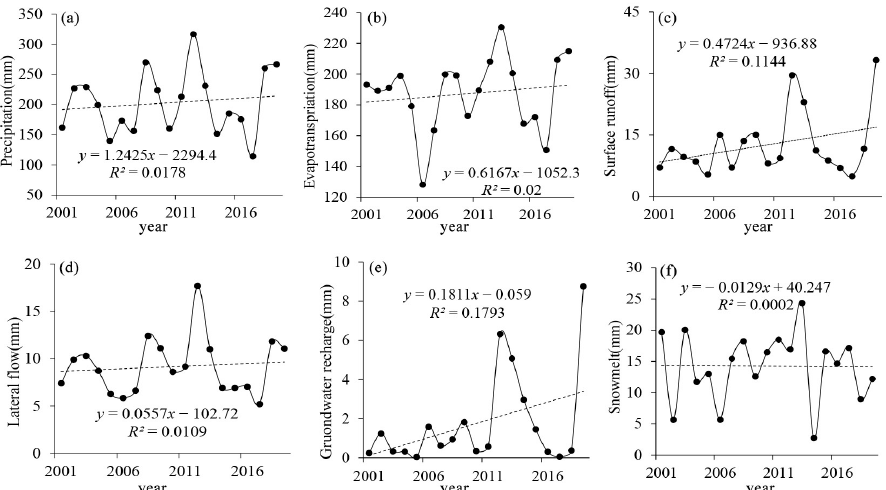
Figure 3. Characteristics of interannual variation in the URB’s hydrological process factors from 2001 to 2019: ( a ) precipitation, ( b ) ET, ( c ) surface runoff, ( d ) lateral flow, ( e ) groundwater recharge, and ( f ) snowmelt. Great spatial heterogeneity was observed in the spatial distribution and variation rates of the URB’s different hydrological process factors (Figure 4). The annual total pre- cipitation in the upstream region of the basin was 457.48 mm, and it gradually decreased from east to west; the overall precipitation variation rate was high, with the fastest varia- tion reaching up to 2.033 mm/yr in the upstream, followed by that in the downstream (1.601 mm/yr; see Figure 4a). The ET in the southern part of URB reached 272.79 mm, while the ET in the northwestern part was lower at 261.74 mm, showing a decreasing trend from south to north. The rate of change was faster in the URB’s upstream and south- ern parts and slower in its northern and downstream parts (Figure 4b). The runoff deep high value of the URB’s runoff was mainly concentrated in the wetland area, decreasing from the wetland to the surrounding area. The rate of change varied similarly, with the downstream wetland area increasing at a rate of 8.23 mm/yr (Figure 4c). The lateral flow in the high-elevation area was higher than that in the low-elevation area; the lateral flow gradually increased from the URB’s wetland to the surrounding area, and the change rate showed the same spatial distribution characteristics as the lateral flow did (Figure 4d). Groundwater recharge reached 3.12 mm in the URB’s upper and western parts and was lower in the URB’s southern and northern parts (1.5 mm); the rate of change was also faster in the higher groundwater recharge areas (Figure 4e). Snowmelt was observed more in the URB’s upper and middle reaches, with the highest value being up to 16 mm. Snow- melt in the middle and south of the lower reaches was less than 6.27 mm. This shows a distribution pattern of gradual decrease from the URB’s northeast to southwest, with the rate of decrease of snowmelt being higher in the middle (Figure 4f). Overall, the precipi- tation and snowmelt in the URB’s upper and middle reaches were high and the runoff depth was small; for the downstream region, it was just the opposite, and the rate of change in the downstream was higher than that in the upstream.